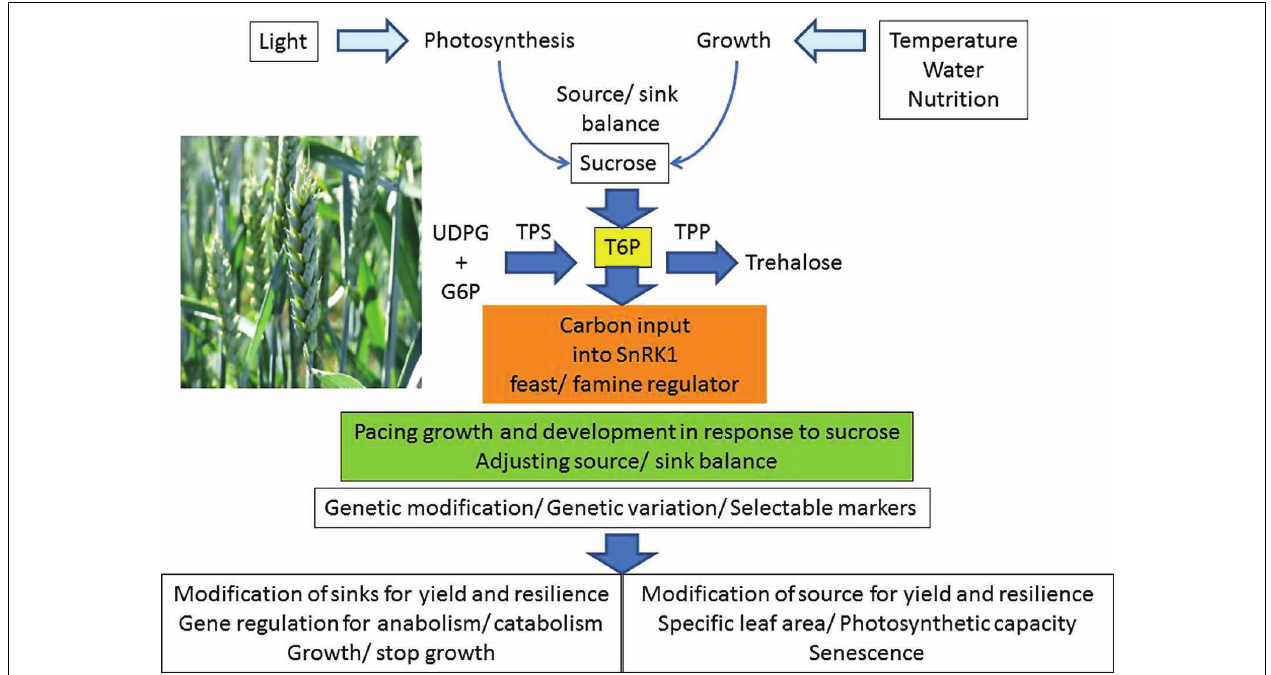
FIGURE 1 | Optimizing sucrose allocation for yield under variable environmental